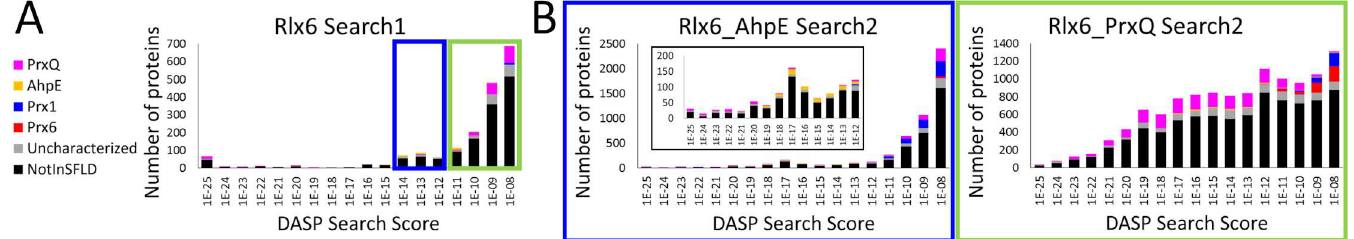
Fig 9. PSSM Analysis subdivides Rlx6 into AhpE and PrxQ groups. (A) The DASP2 score distributionof the Rlx6 Search1 results is shown with bars colored by known functionalannotations(see legend).The blue and green boxes represent the two groupsidentifiedby PSSM Analysis.(B) The DASP2 score distributionsthat result from Search2, which uses as input the ASPs composedof the proteins in the blue and green boxes from (A). Search2 results illustrate the separationof the AhpE (orange)and PrxQ (pink) subgroups. An inset shows more detail for scoringbins 1e-25 to 1e-12 for the Rlx6_AhpE Search2